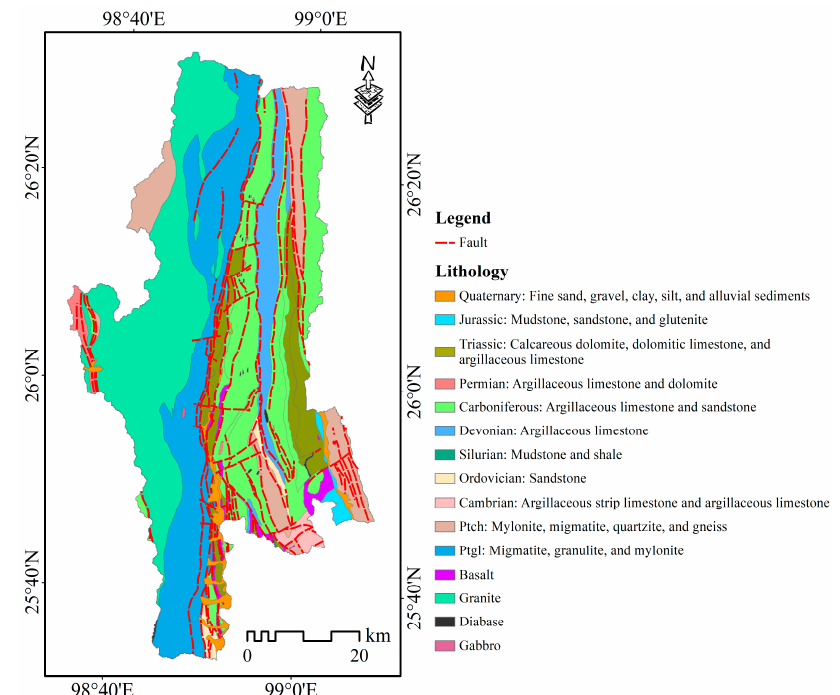
Figure 2. Position of the study area.